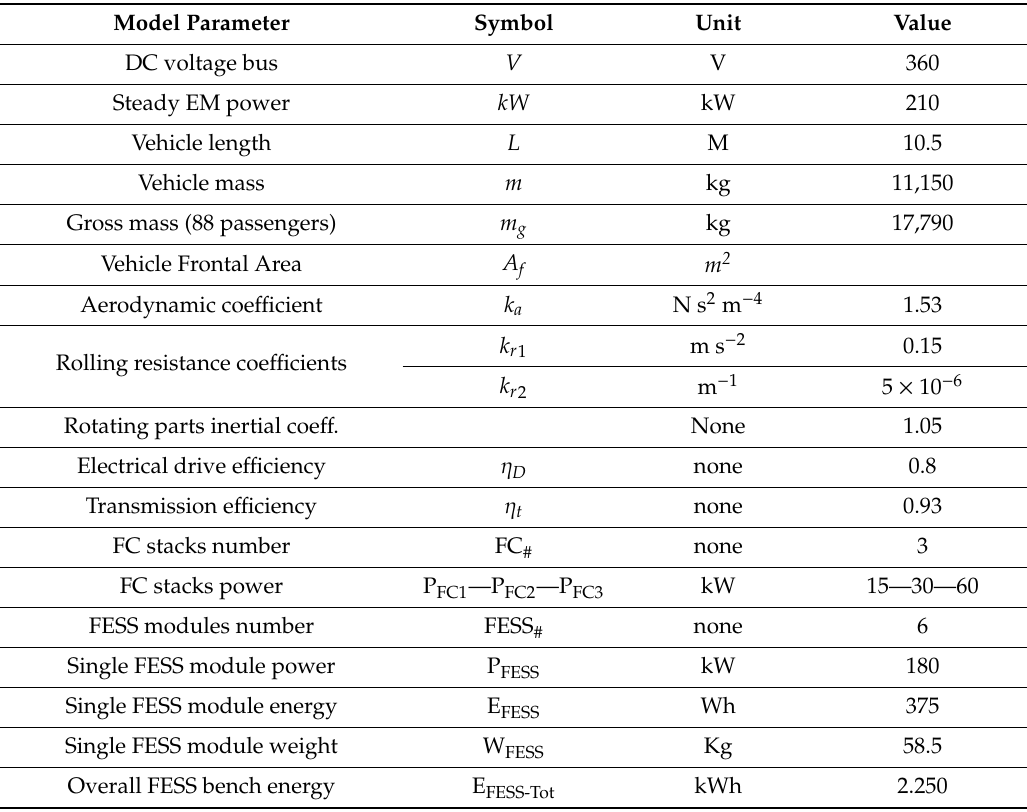
Table 1. Vehicle and power unit